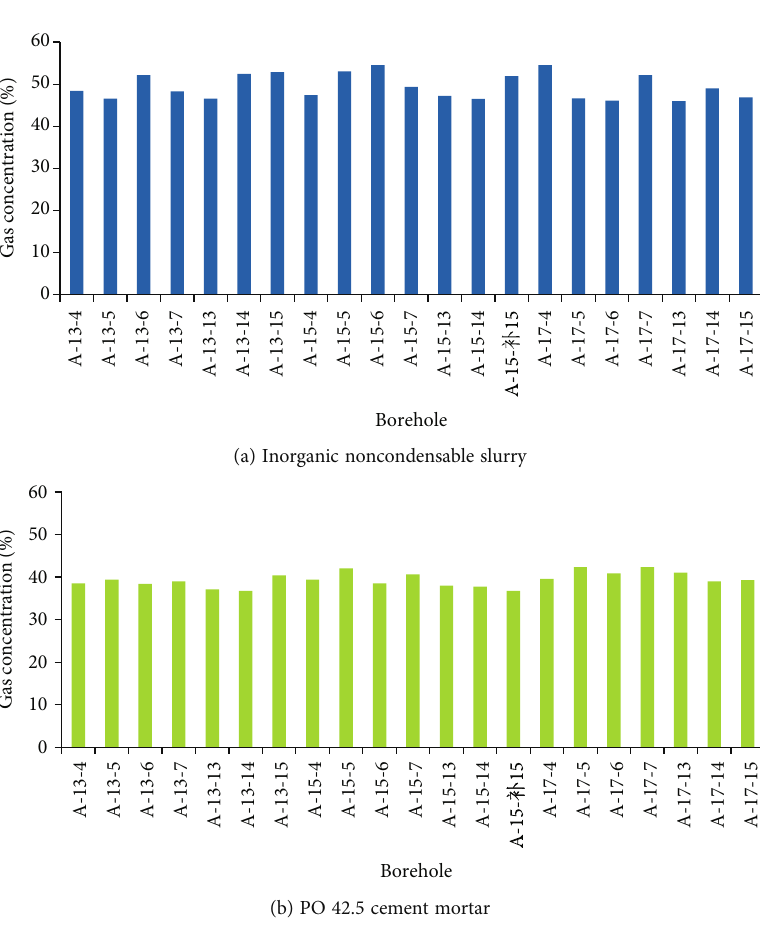
Figure 14: Average gas concentration in the two group boreholes.